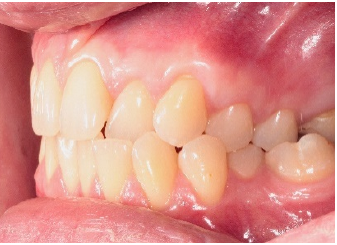
Figure 11. Control group patient: Clinical situation 24 months after treatment of multiple adjacent gingival recessions.